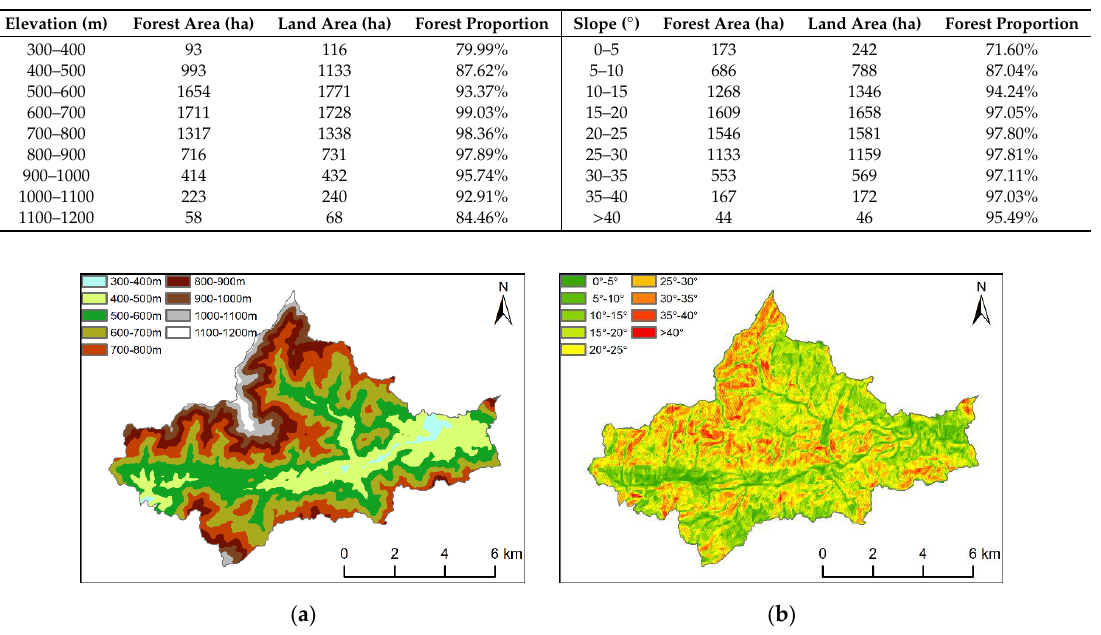
Table 4. Details of the elevation and slope zones.